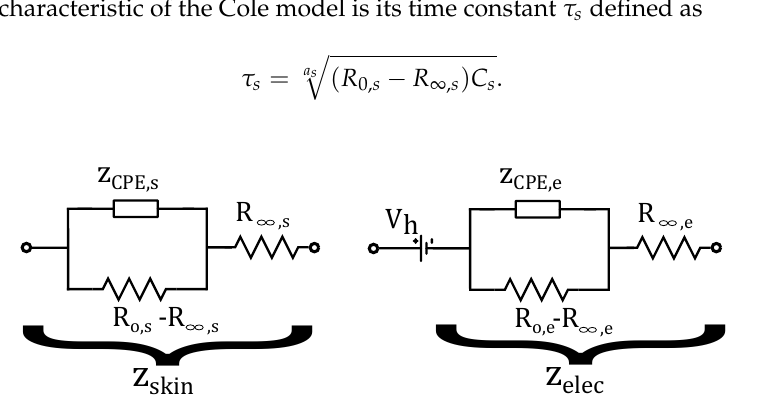
Figure 2. Cole models of the skin ( left ) and electrode ( right